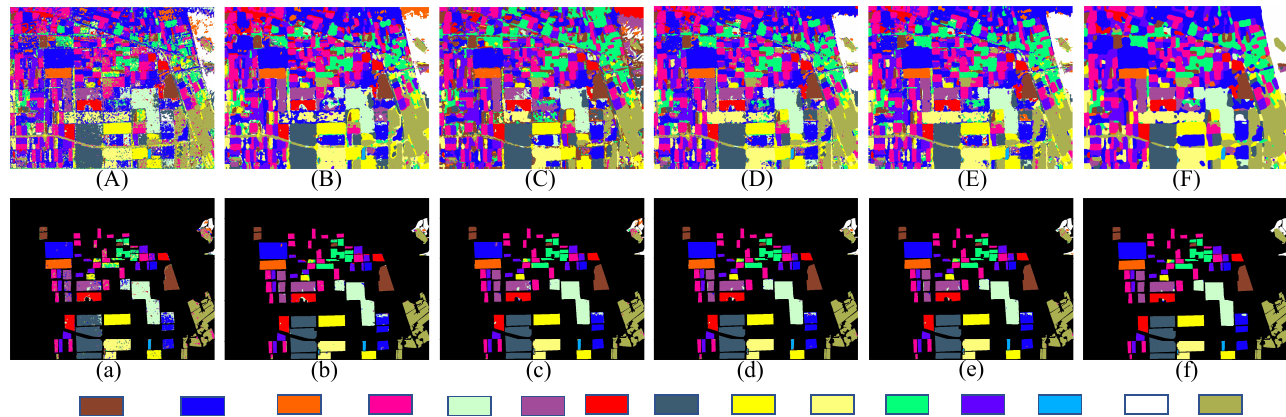
Figure 8. Classification maps of the AIRSAR Flevoland dataset. ( A ) 1D-CNN. ( B ) 2D-CNN. ( C ) DenseNet. ( D ) CapsNet. ( E ) CapsNet-3. ( F ) Proposed method. ( a – f ) are the masked results according to the ground truth of ( A ), ( B ), ( C ), ( D ), ( E ), and ( F ), respectively.